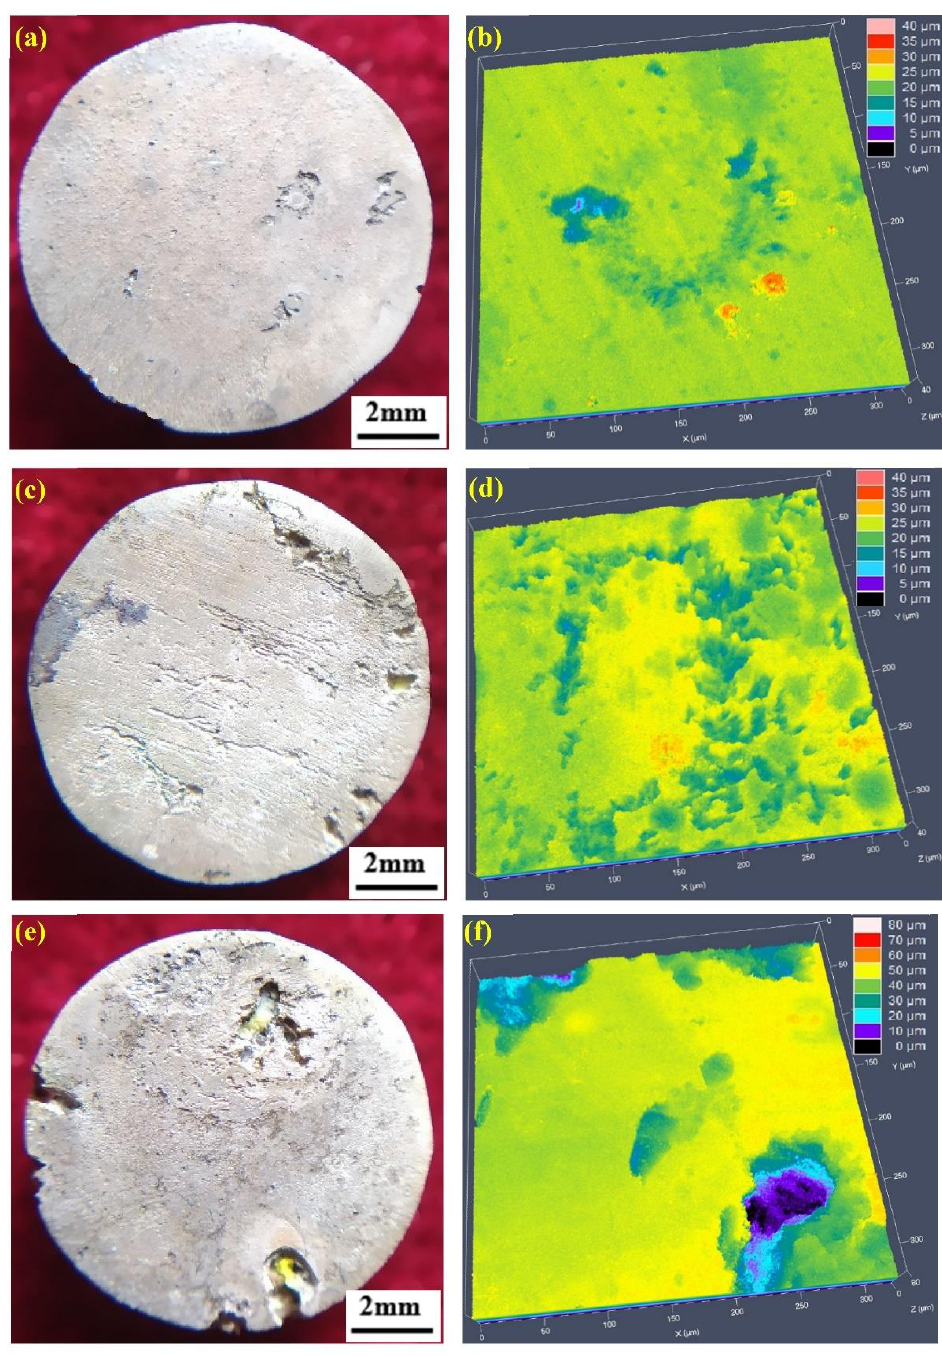
Figure 7. Surface morphologies ( a , c , e )and topographic maps ( b , d , f ) of the representative annealed conditions: ( a , b ) for annealed at 350 °C, ( c , d ) for annealed at 450 °C, ( e , f ) for annealed at 500 °C. conditions: ( a , b ) for annealed at 350 ◦ C, ( c , d ) for annealed at 450 ◦ C, ( e , f ) for annealed at 500 ◦